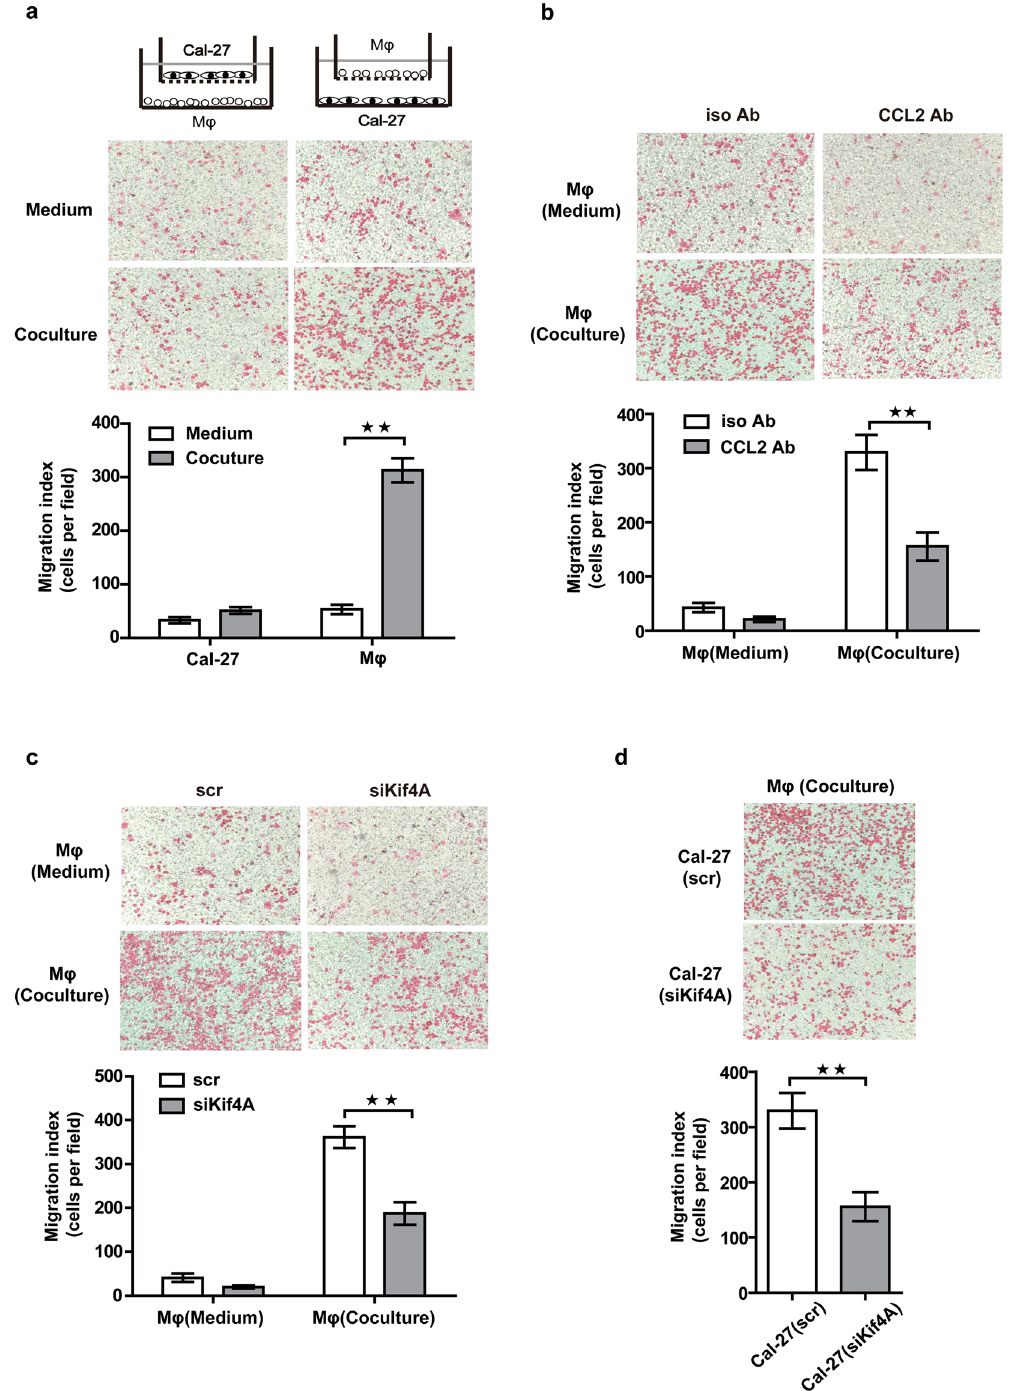
Figure 3. Kif4A-CCL2 promoted the recruitment of the macrophage towards Cal-27. ( a ) Migration assay of Cal-27 towards THP-1-derived macrophages and THP-1-derived macrophages towards Cal-27 was achieved as described in the Methods Medium in lower chambers without cells groups were use as control. ( b ) The migrated THP-1-derived macrophages towards Cal-27 with/without CCL2 neutralizing antibody or isotype antibodies (10 μ g/mL) were counted. ( c ) Migration assay of THP-1-derived macrophages, with scr or siKif4A pre-treated, towards Cal-27 was achieved. Medium in lower chambers without cells groups were use as control. ( d ) The migrated THP-1-derived macrophages towards Cal-27, with scr or siKif4A pre-treated, were counted. Pictures were magnified at 100 × , Bars in graphs ( a – d ) are representative of 5 independent experiments and all data are shown as the mean ± SEM. ** p <